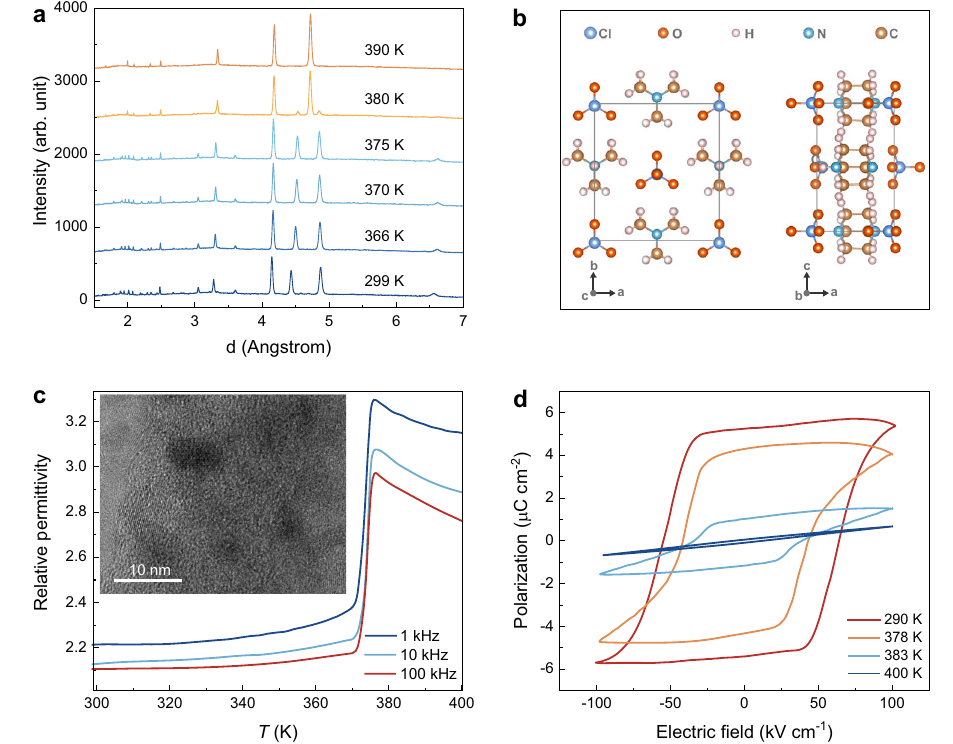
Fig. 2 | Structural and dielectric properties of energetic [Hdabco]ClO 4 . a Neutron diffraction patterns at different temperature for energetic [Hdabco] ClO 4 . b Crystal structure for the ferroelectric phase of energetic [Hdabco]ClO 4 . c Temperaturedependenceofrelativepermittivityforenergetic[Hdabco]ClO 4 at1,